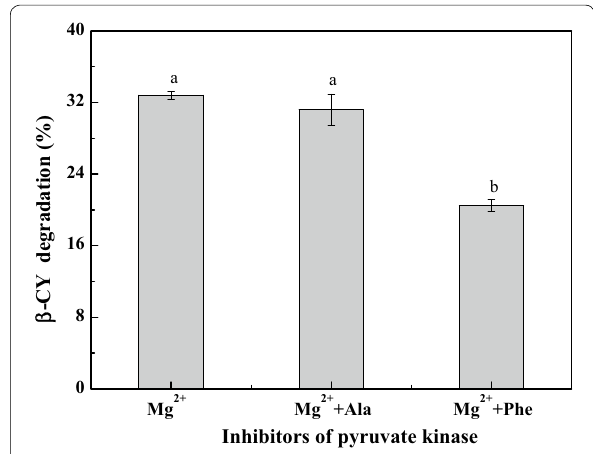
Fig. 3 Effect of pyruvate kinase inhibitors on co-metabolic degradation of β-CY by strain B-1. Data are presented as mean standard deviation of three replicates; the standard ± deviations are within 5% of the mean. Different letters indicate significant differences ( p < 0.05)